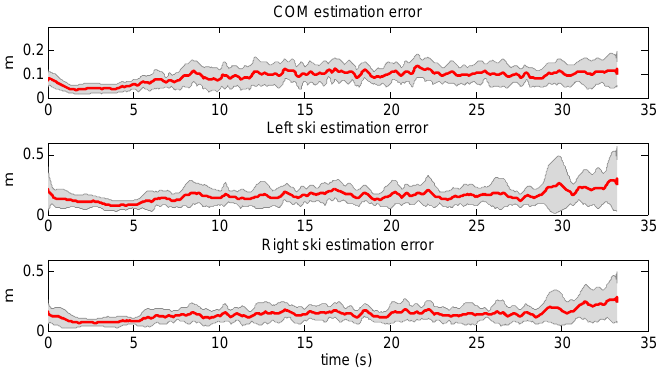
Figure 11. Mean error between the estimated and true value of COM positions and both skis positions by using NN for all 18 ski runs. Yellow, green blue and red lines denote the antenna trajectory, COM trajectory and left and right skis trajectories, respectively. Measured trajectories are solid lines, and estimated ones are denoted with dotted